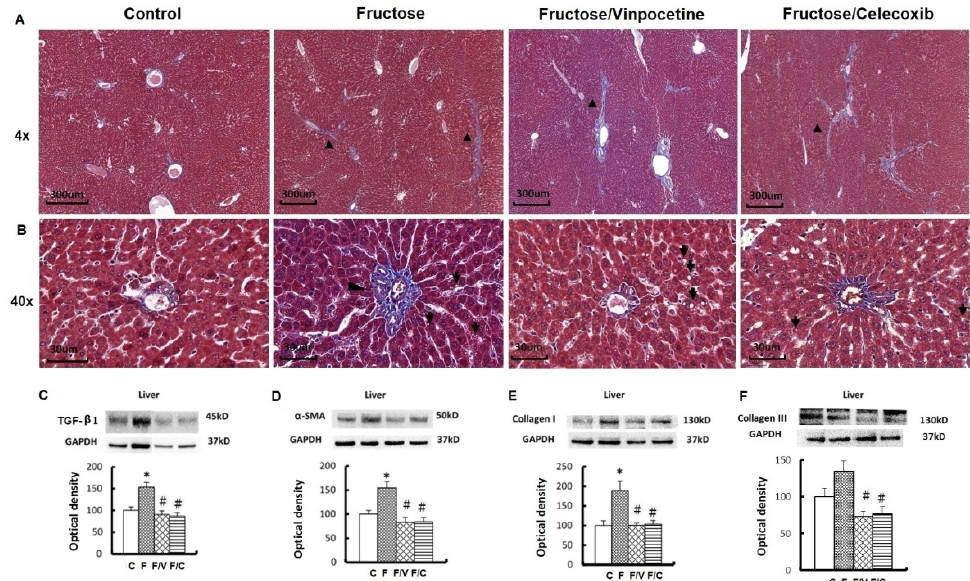
Figure 3. The effects of long-term fructose feeding on hepatic fibrosis, lipid steatosis, and fibrogenesis markers. ( A ) Masson’s trichrome stain of liver tissues in different groups. Arrowhead: the zone-3 perisinusoidal fibrosis. Reduced from 4 × . ( B ) Masson’s trichrome stain of liver tissues in different groups. Arrowhead indicates fibrous portal expansion in the fructose-only group. Arrow: lipid steatosis in all fructose groups. Reduced from 40×. ( C – F ) Western blots of TGF- β 1, α -SMA, collagen I, and collagen III, respectively, of liver tissues among groups. Data are expressed as mean ± SEM. n = 8. * p < 0.05 versus controls and # with versus fructose group.